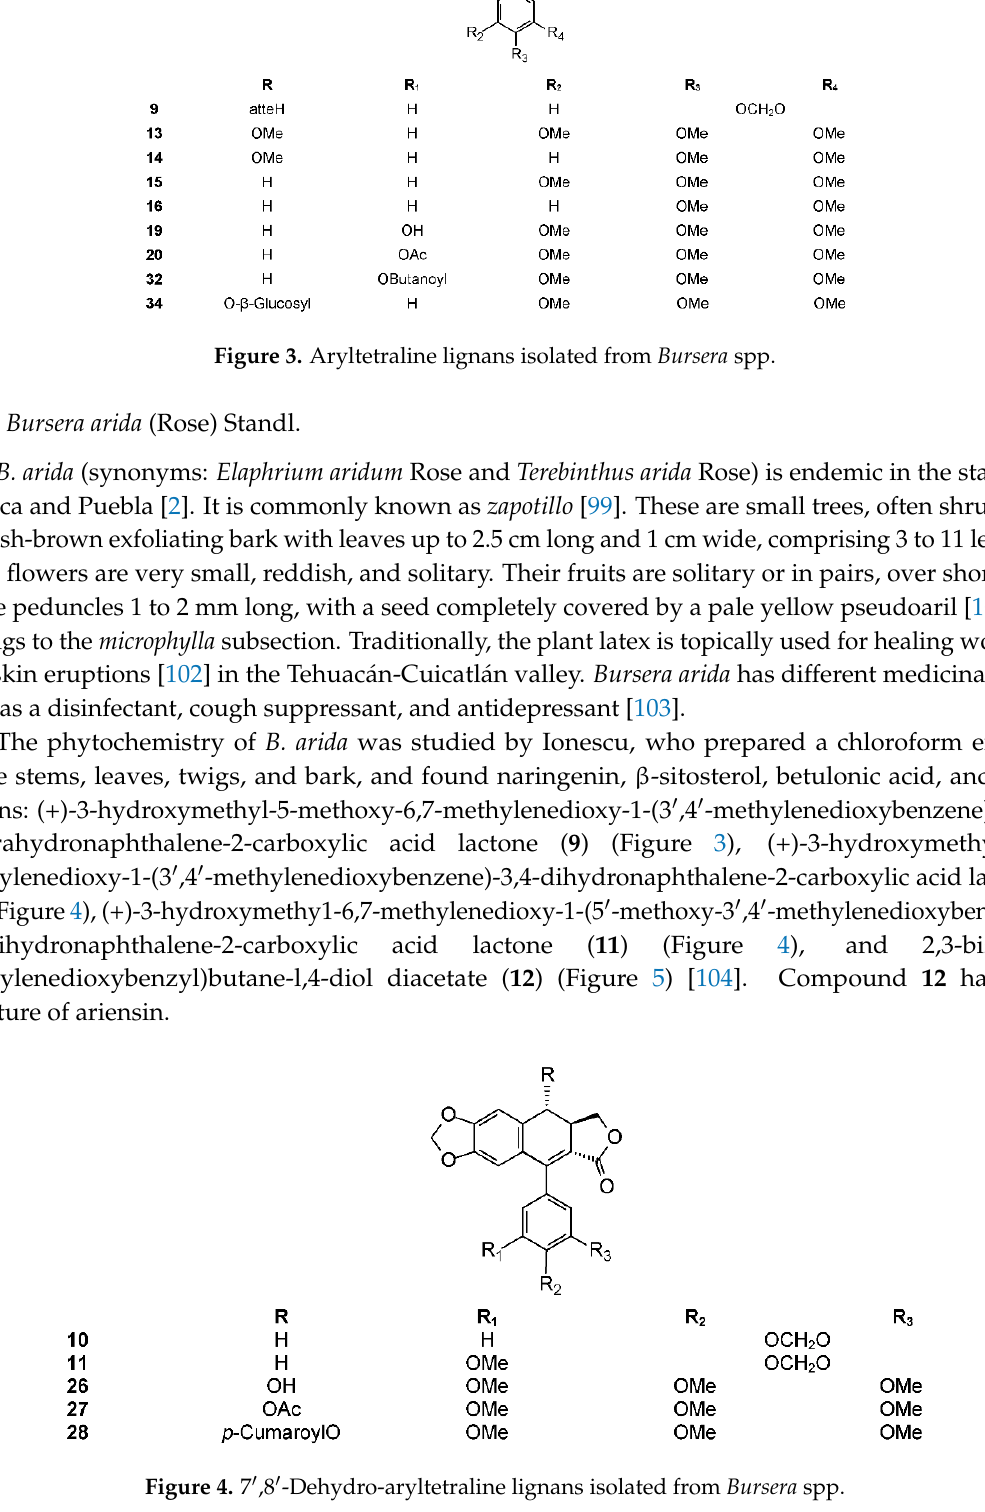
Figure 5. Dibenzylbutane diol lignans isolated from Bursera spp. 2.3.3. Bursera ariensis (Kunth) McVaugh and Rzed. B. ariensis (synonyms B. panosa Engl., B. sessiflora Engl., E. ariensis Kunth, and E. brachypodium Rose). These are trees and sometimes shrubs between 2 and 8 m tall with greenish ‐ gray trunks and